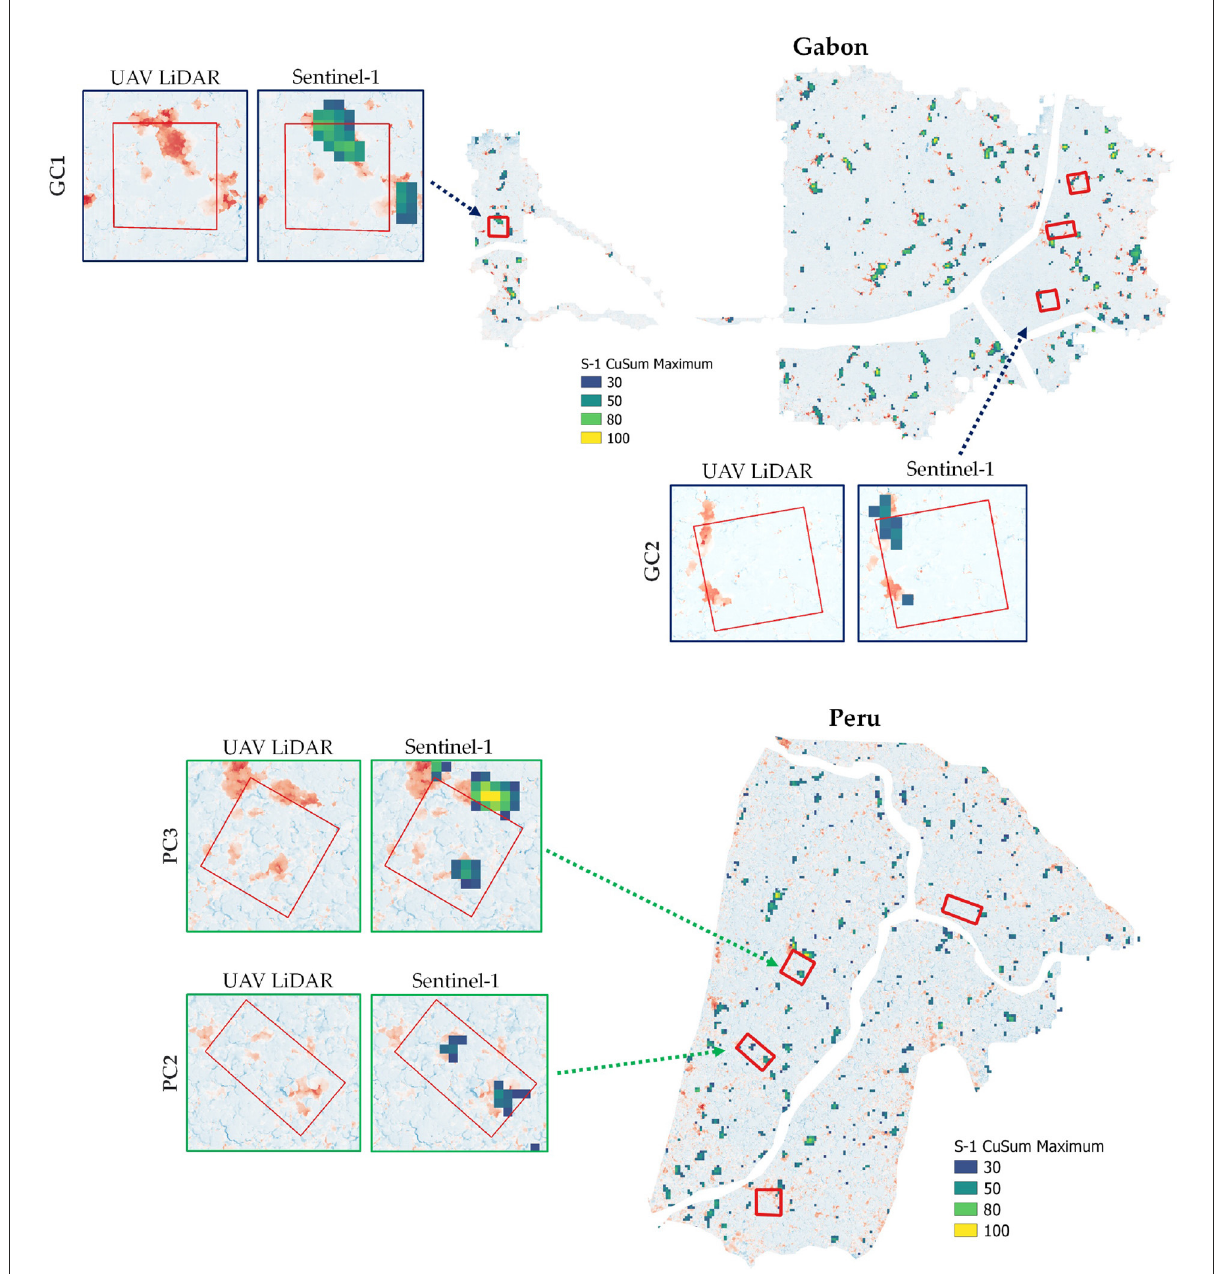
FIGURE6 Results of the CuSum change detection algorithm showing the location of the forest disturbance pixels in the study areas in Gabon (top) and Peru (bottom). The inlets are zoomed views of two selectively logged plots for each study area. The left inlets are the UAV LiDAR reference map (25 cm resolution), with areas of canopy height loss appearing in red. The right inlets show clusters of disturbances pixels from the CuSum algorithm applied to Sentinel-1 data overlaid on the LiDAR reference map.